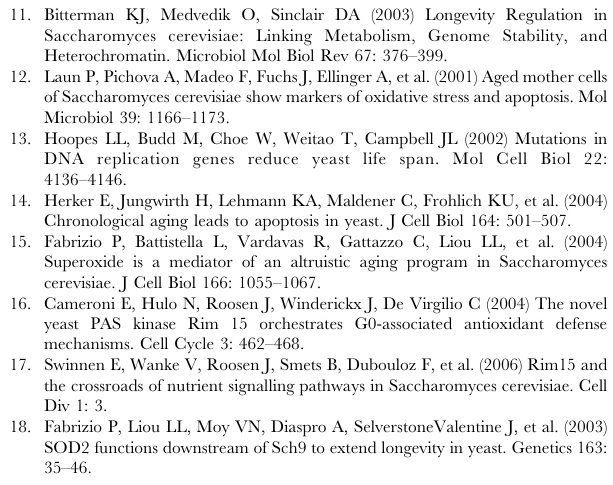
Figure S2 Effect of osmotic stress.